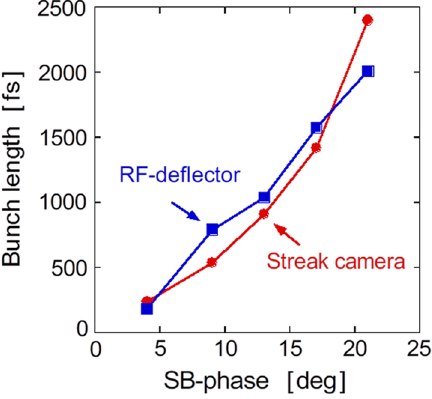
FIG. 33. Correlation data of the bunch-length variation mea- sured with a streak camera and the rf